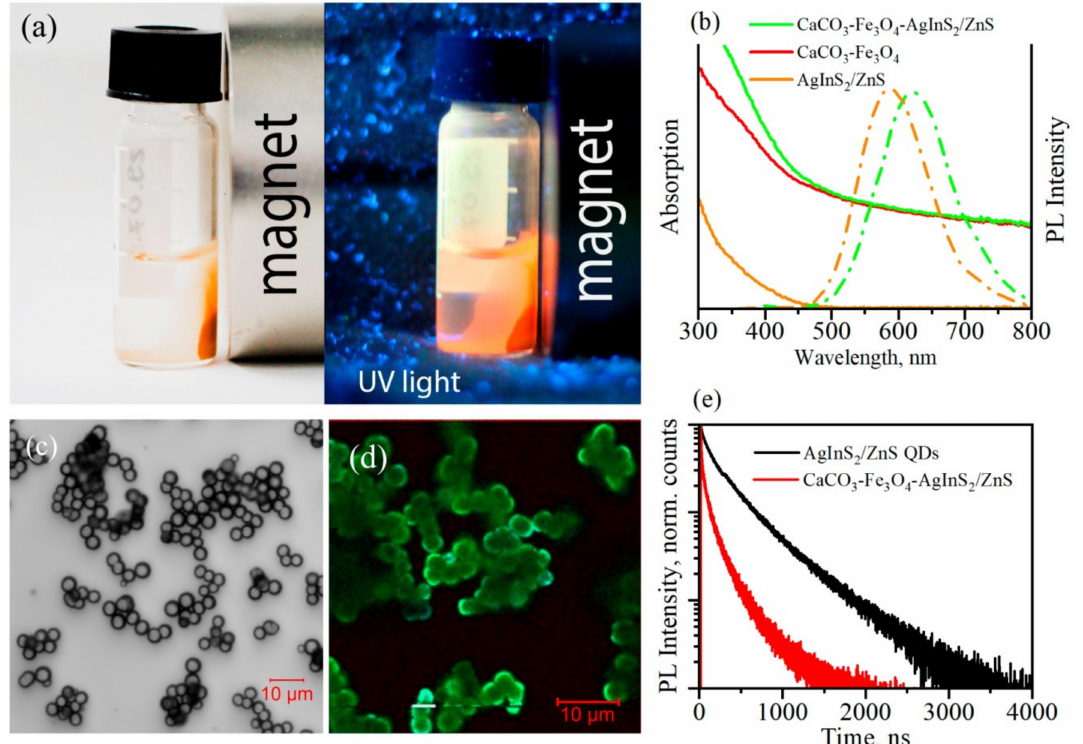
Figure 2. Optical and magnetic properties of the CFA fluorescent sensor. ( a ) Photos of the accumulation of the microspheres to magnetic bar under UV light, ( b ) Absorption (solid line) and photoluminescent (PL) (dash / dotted line) spectra of the CFA fluorescent sensor and AgInS 2 / ZnS QDs in water (orange AgInS 2 / ZnS QDs, red CaCO 3 -Fe 3 O 4 microspheres, and green CFA fluorescent sensor), ( c ) Confocal transmitted light images of the CFA microspheres, ( d ) Fluorescence-Lifetime Imaging Microscopy (FLIM) images of the CFA microspheres, ( e ) PL decay curves of the CFA microspheres and the aqueous dispersion of the initial AgInS 2 / ZnS QDs. The PL measurements shown in panels ( b − e ) were done at 350 nm